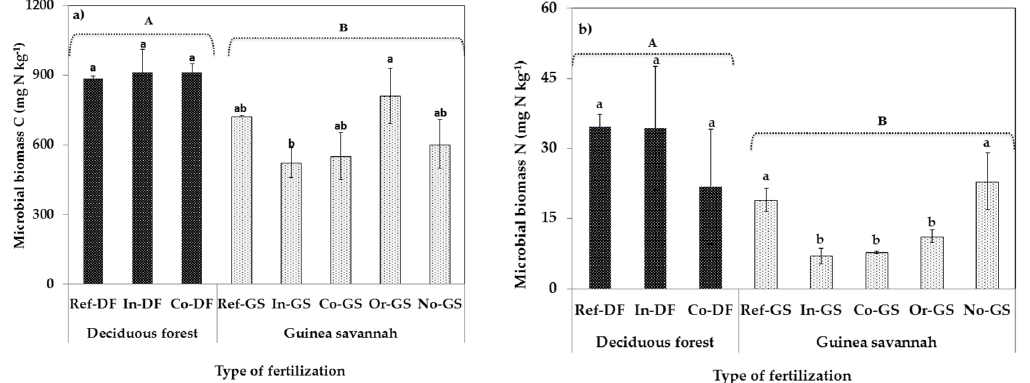
Figure 1. Soil microbial biomass C ( a ) and microbial biomass N ( b ) at depth (0–15 cm) of different types of fertilization. Treatment code: Ref-DF, reference DF site; In-DF, inorganic fertilization at DF; Co-DF, inorganic fertilizer, with low-to-medium organic residues at DF; Ref-GS, reference site;